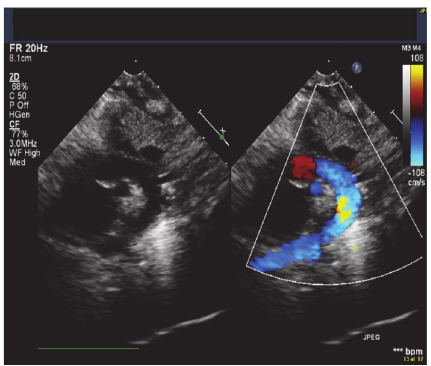
Figure1:Echocardiogram(suprasternalview)demonstratinganor- mal aortic arch without any evidence of coarctation prior to patent ductus arteriosus ligation surgery.